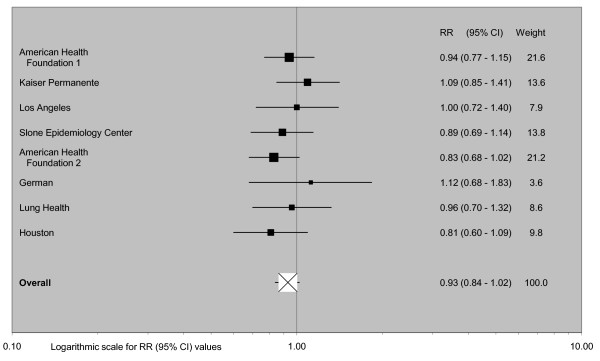
Forest plot of study-specific estimates and 95% CIs for mentholated cigarette use. The figure plots the eight combined gender/combined race estimates for use of mentholated cigarettes in ever smokers (or current smokers if not available). Precise definitions of the comparison used for each study are given in Table 17. Each estimate is shown as a square with its area proportional to its weight. The CI is indicated by a horizontal line. The data are plotted on a logarithmic scale so that the estimate is centred in the CI. Also shown in the plot are the actual values of the estimate and its CI and weight. Results from a random effects meta-analysis are also shown. The combined estimate is presented as a diamond with the width corresponding to the CI, and the estimate as the centre of the diamond.